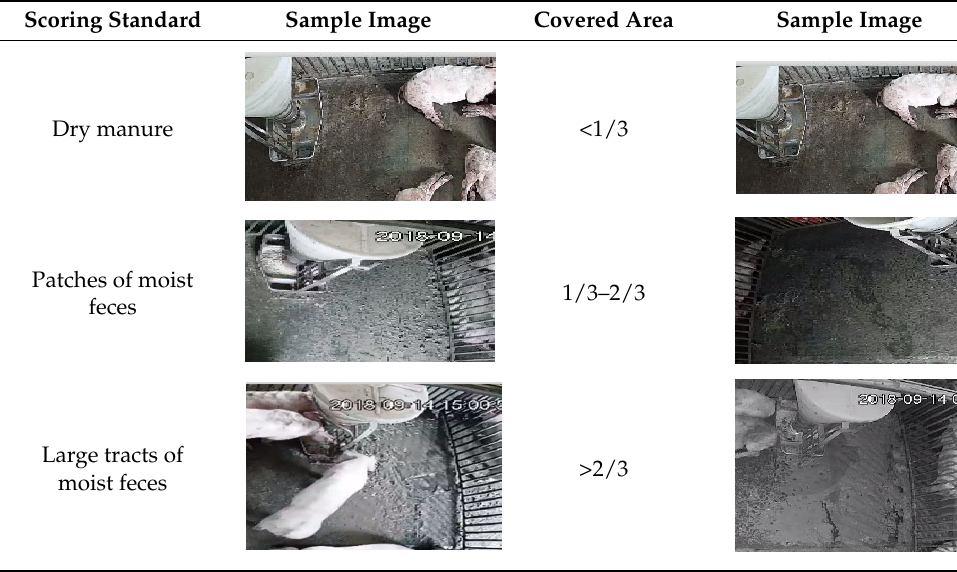
Table 2. Live pictures corresponding to the scoring standards.